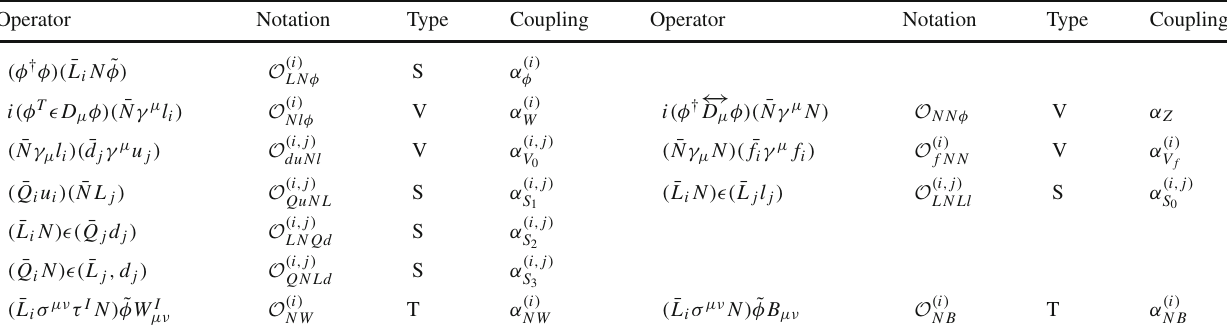
Table 1 Basis of dimension d = 6 baryon (and lepton) number con- U ( 1 ) Y and SU ( 2 ) L field strengths, respectively. Also, σ μν is the Dirac serving operators with a right-handed neutrino N [6,8]. Here, l i , u i , d i tensor, γ μ are the Dirac matrices, and (cid:9) = i σ 2 is the antisymmetric symbol in two dimensions. Types S, V, and T stand for scalar, vectorial, and L i , Q i denote, for the family labeled i , the right-handed SU ( 2 ) and tensorial (one-loop level-generated) structures singlet and the left-handed SU ( 2 ) doublets, respectively (collectively f i ). The field φ is the scalar doublet, and B μν and W I μν represent the Operator Notation Type Coupling Operator Notation Type